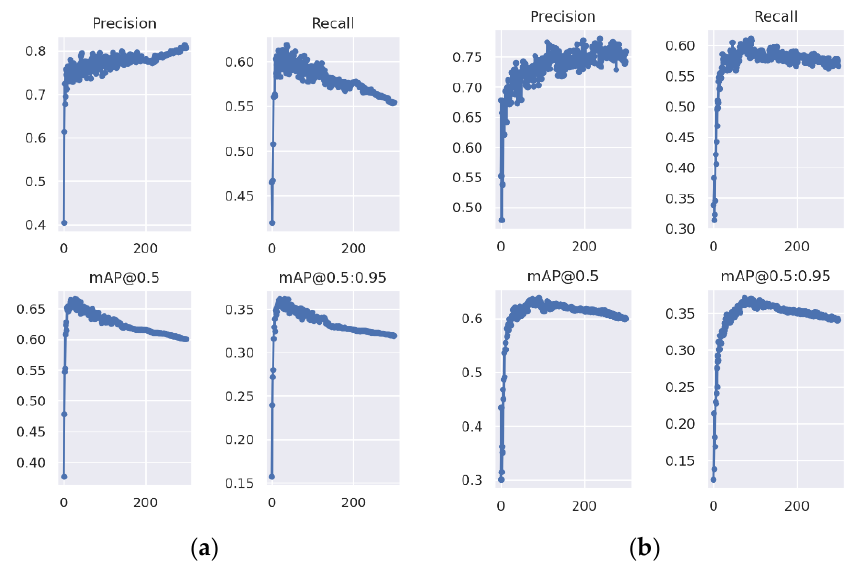
Figure 17. The performance of the model in the test set when trained with and without non-overlapping fi lling of scarce samples: ( a ) the performance of the model trained without non-overlapping fi lling; and ( b ) the performance of the model trained with non-overlapping fi lling.